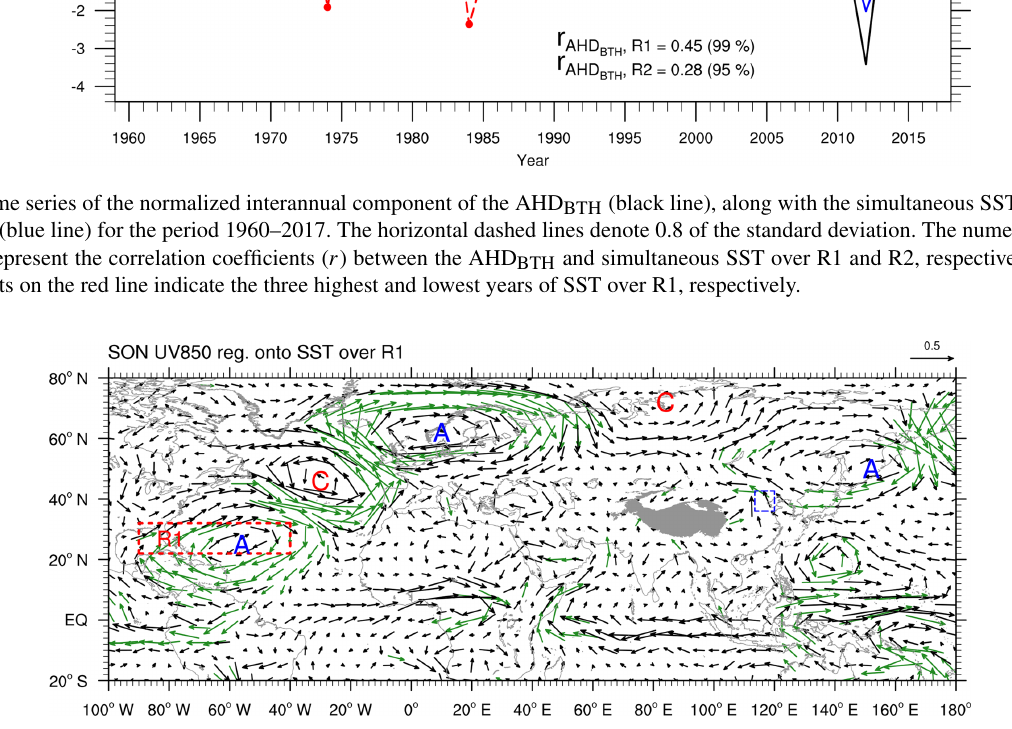
Figure 7. Regressed anomalies of autumnal UV850 (vectors; ms − 1 ) with respect to the simultaneous interannual component of the SST over R1. Green arrows represent the wind vectors with statistical significance above the 90% confidence level. The red dashed rectangle labeled R1 is the key region where SSTAs are significantly correlated with the interannual component of the AHD BTH . The blue dashed box delineates the research domain of the BTH region. The gray shaded area denotes the Tibetan Plateau. The letters A and C represent the centers of anticyclonic and cyclonic anomalies,